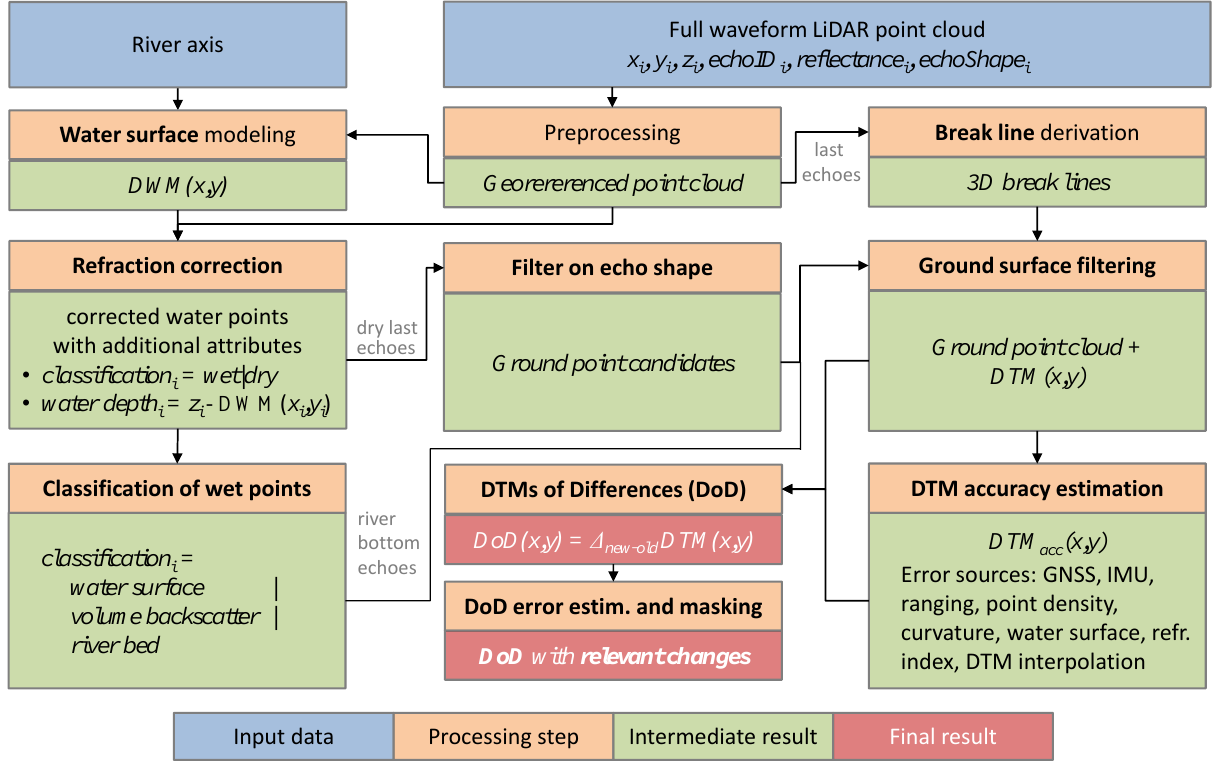
Figure 3. Overview on